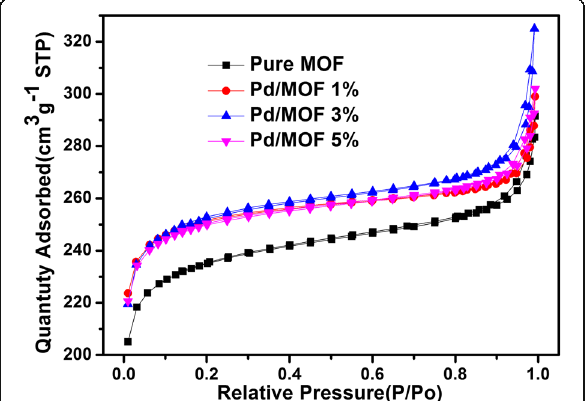
Fig. 5 The N 2 adsorption – desorption isotherms of pure MOF, Pd/ MOF 1%, Pd/MOF 3%, and Pd/MOF 5%